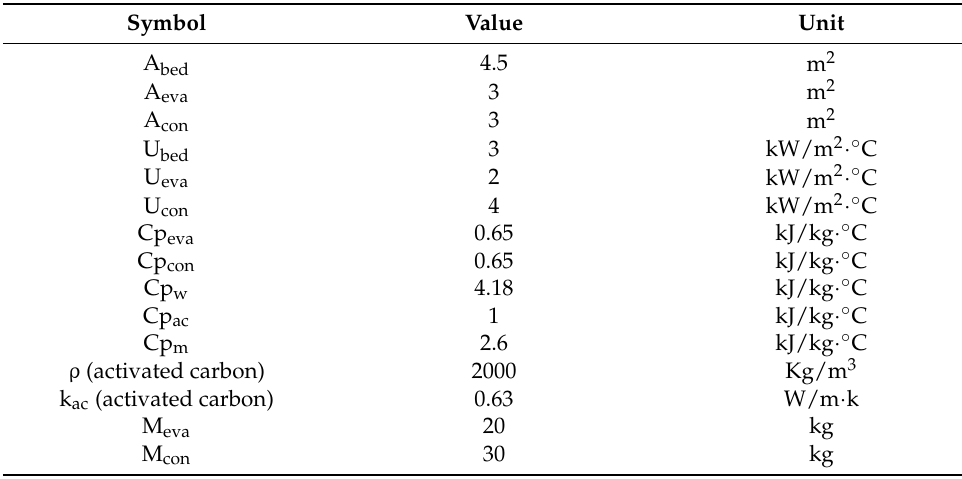
Table A1. Parameters Used in Simulation.